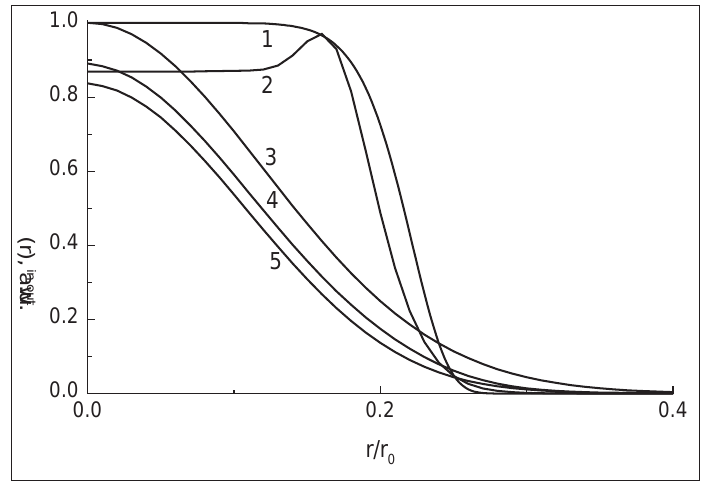
Figure1.Transversedistributionofincidentandabsorbertransmittedpulses:supergaus-